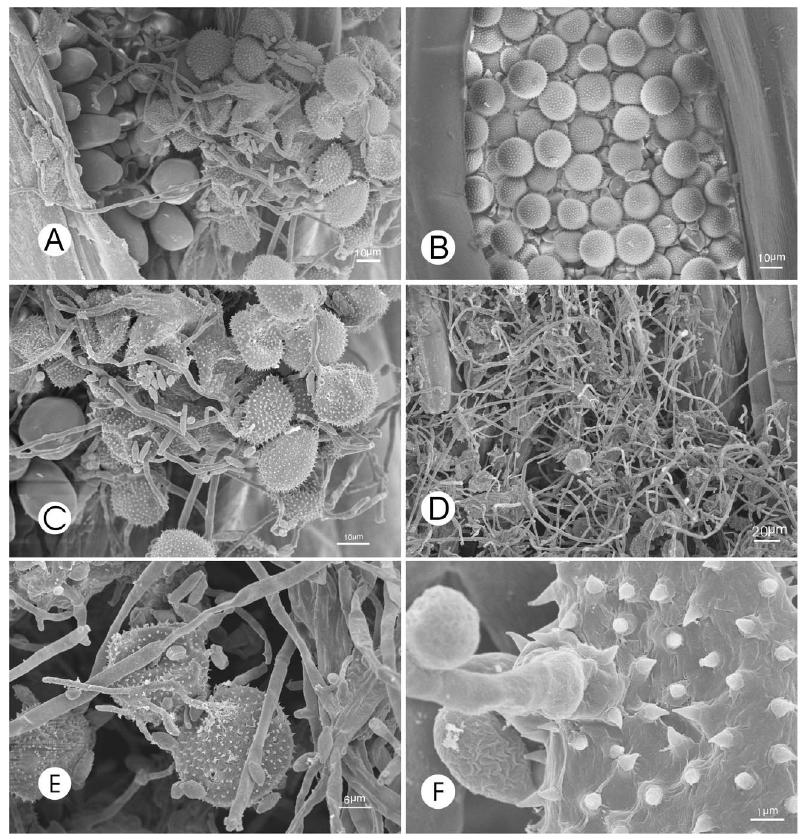
Figure 1. Uredinia and urediniospores of Pst are parasitized by Cladosporiumcladosporioides . A : A uredinium infected by C . cladosporioides ( 6 800), B : A non-infected uredinium filled with urediniospores ( 6 700), C : Hyphae of C. cladosporioides growing from or between urediniospores at an early stage of infection ( 6 2,000), note the shriveled urediniospores, D : Numerous hyphae of C. cladosporioides growing on a uredinium at a late stage of infection ( 6 400), note presence of very few normal urediniospores, E : Urediniospores invaded by C. cladosporioides hyphae ( 6 1,800), F : High magnification of a C. cladosporioides hypha invading a urediniospore ( 6 11,000).